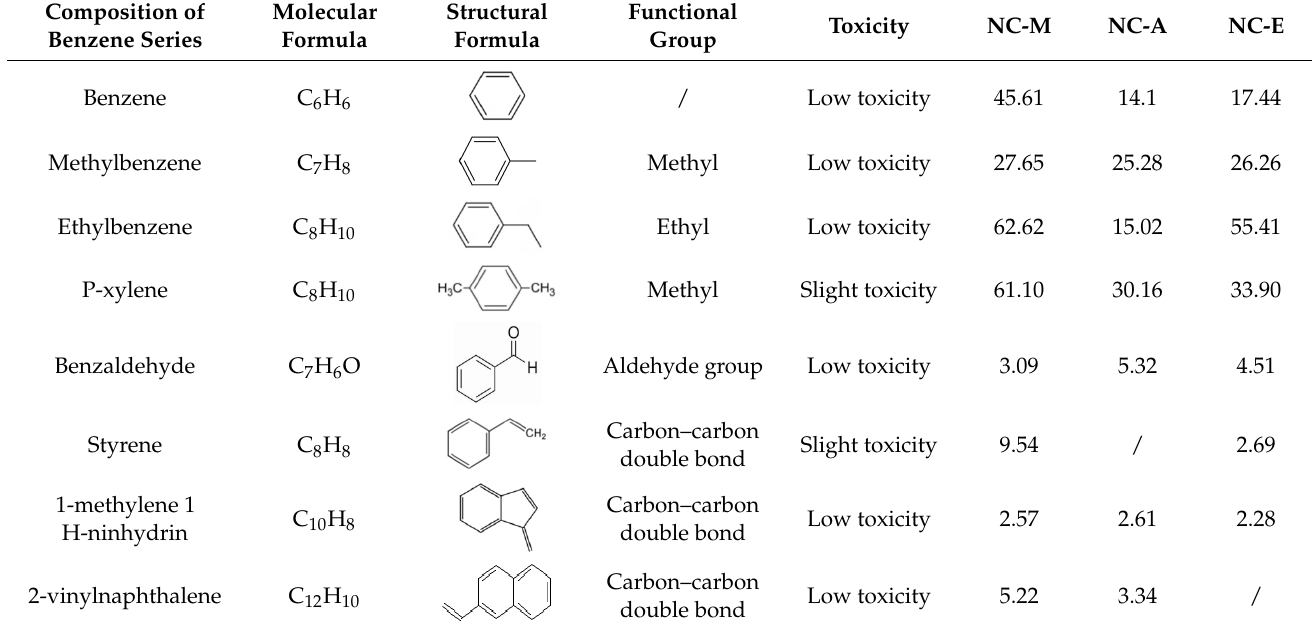
Table 2. The Benzene Series and total concentration released from NC-painted MDF prepared with three diluents ( µ g · m − 3